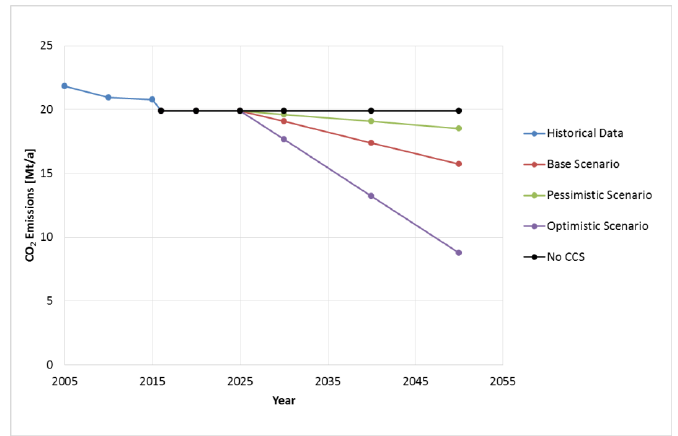
Figure 9. CCUS Germany: CO 2 emission projections for low clinker production. (historical data from UBA/VDZ [21,51]).